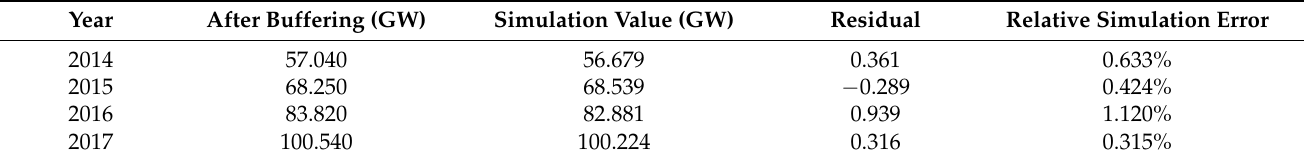
Table 1. Simulation value and simulation error for China.